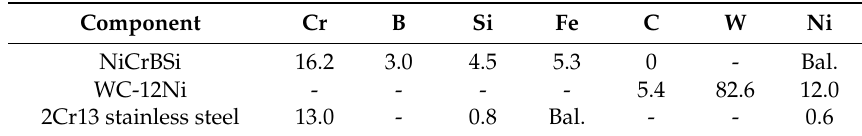
Table 1. Compositions of NiCrBSi, Tungsten Carbide (WC)-12Ni Powder and 2Cr13 Stainless Steel